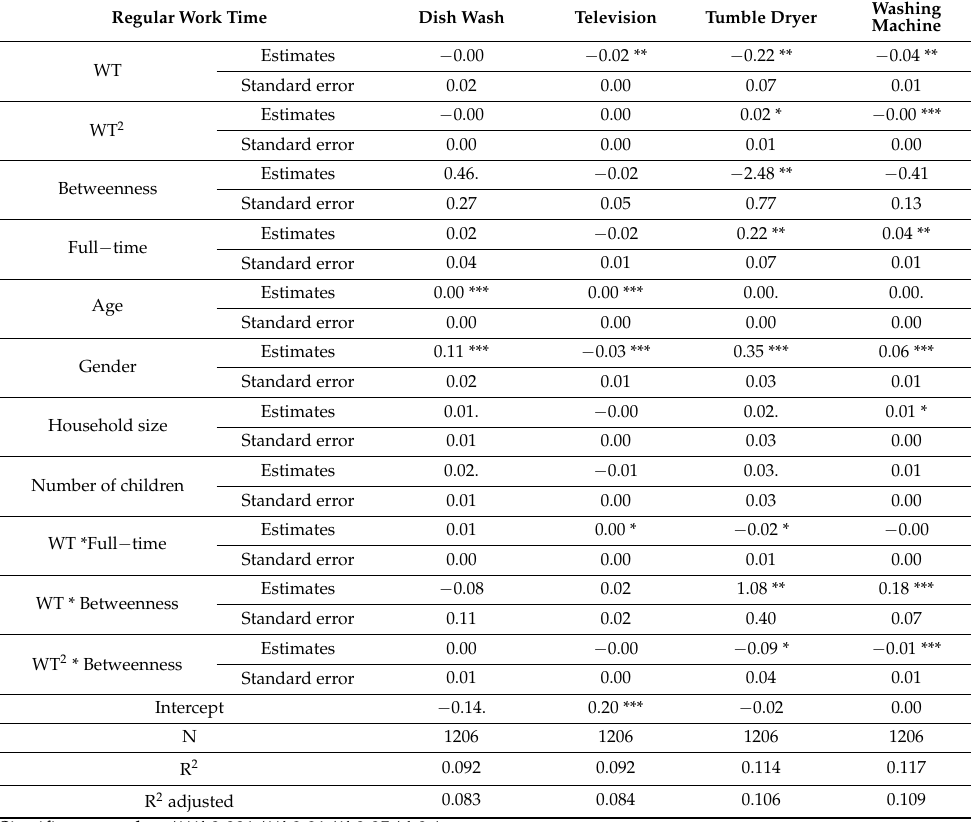
Table 6. Marginal effect of regular work time on energy intensity.